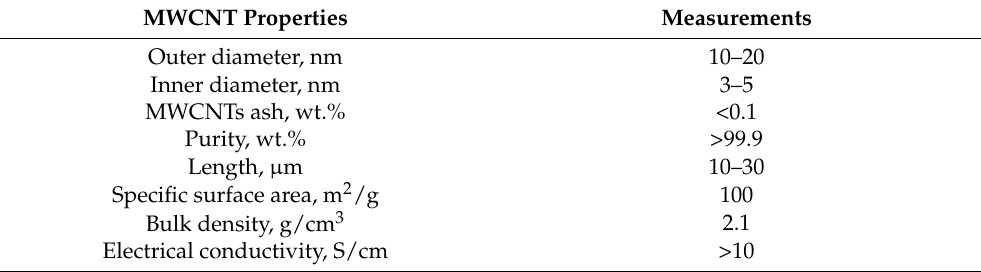
Table 1. Properties of multi-walled carbon nanotubes (MWCNTs) (Cheap Tubes, Inc., Grafton, VT, USA).